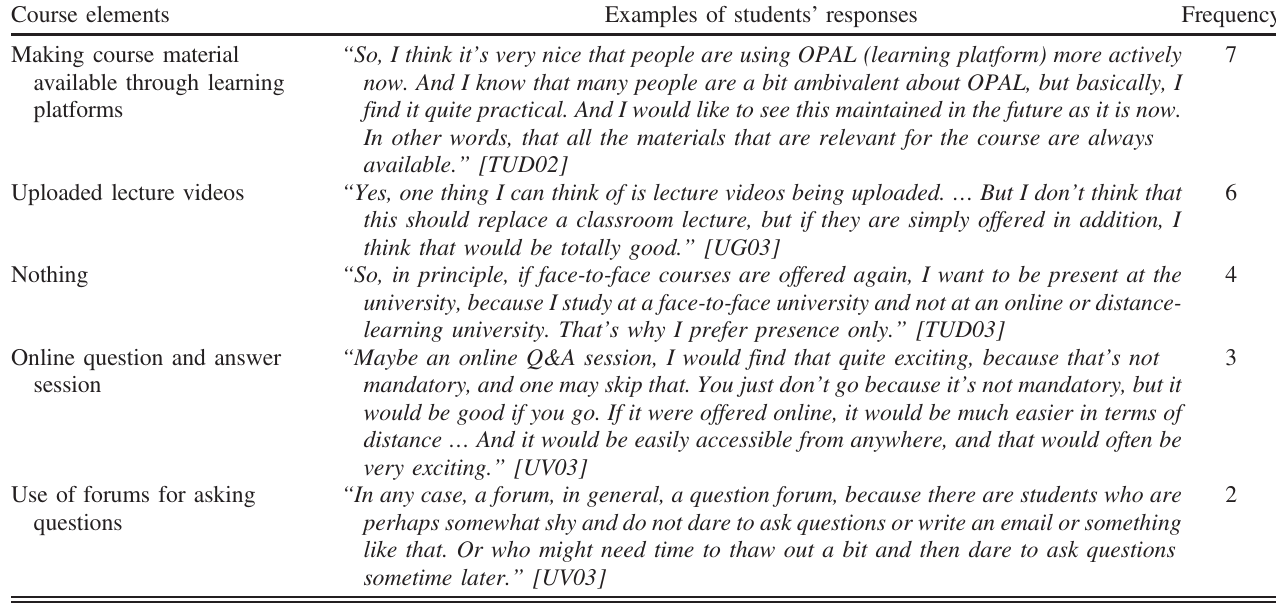
TABLE XI. Course elements from the COVID-19 semester that students would like to preserve in the future.